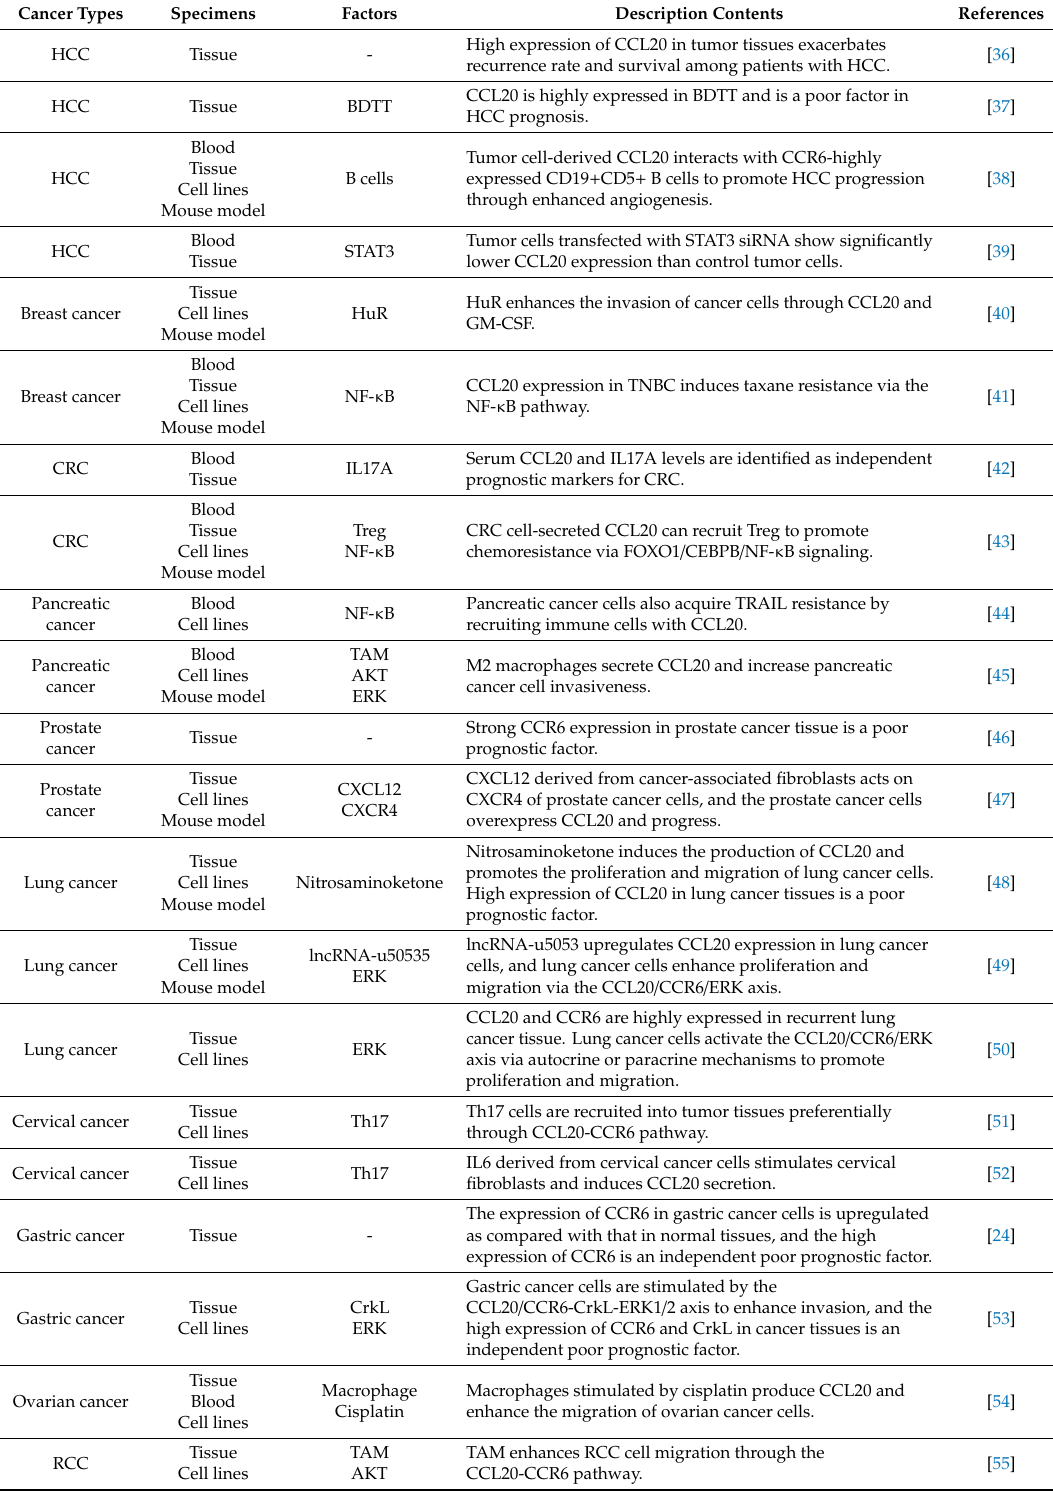
Table 1. Tumor promoting e ff ects of CCL20 within the tumor